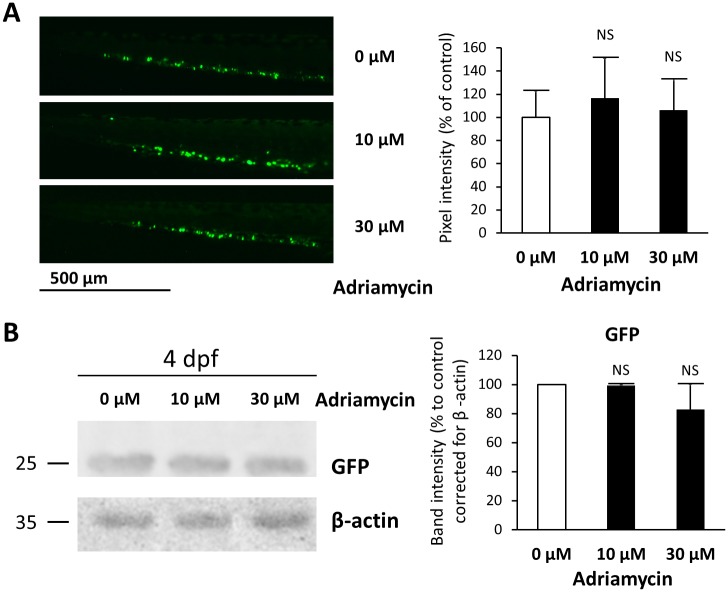
Quantification of thrombocytes in adriamycin treated zebrafish.(A) LEFT: GFP-labeled thrombocytes and thrombocyte precursors are formed in the zebrafish caudal hematopoietic tissue (CHT). Representative pictures of the CHT region at 4 dpf of embryos exposed to adriamycin 0, 10 and 30 μM are shown. No obvious difference in thrombocytes was observed between the controls and the adriamycin exposed fish. RIGHT: Pixel intensity was measured using ImageJ software. The graph represents means ± SD from measurements in three embryos per condition. No significant difference was observed between adriamycin exposed and control embryos. (B) LEFT: Western blot for GFP and β-actin (loading control) was performed using total zebrafish lysates at 4 dpf. A representative blot is shown. RIGHT: Signal intensity was measured using ImageJ software. The graph represents means ± SD from measurements in two repeated experiments. No significant difference was observed between adriamycin exposed and control embryos.